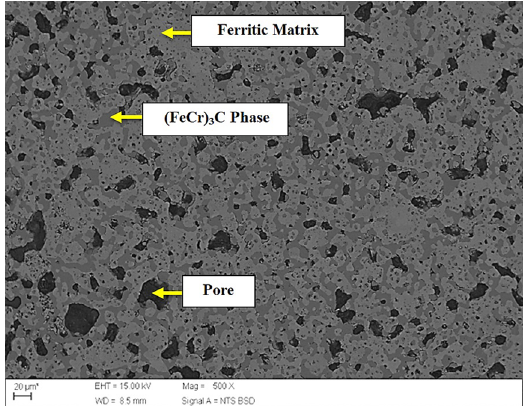
Figure 9. SEM of the AISI 52100 steel showing its